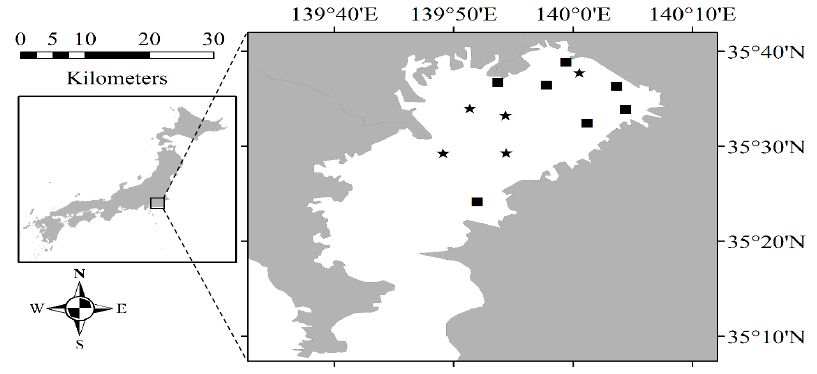
Figure 1. Tokyo Bay with the location of the sampling points. The squares denote stations with measurements of only water quality parameters and the stars represent stations with measurements of water surface reflectance values along with water quality parameters.